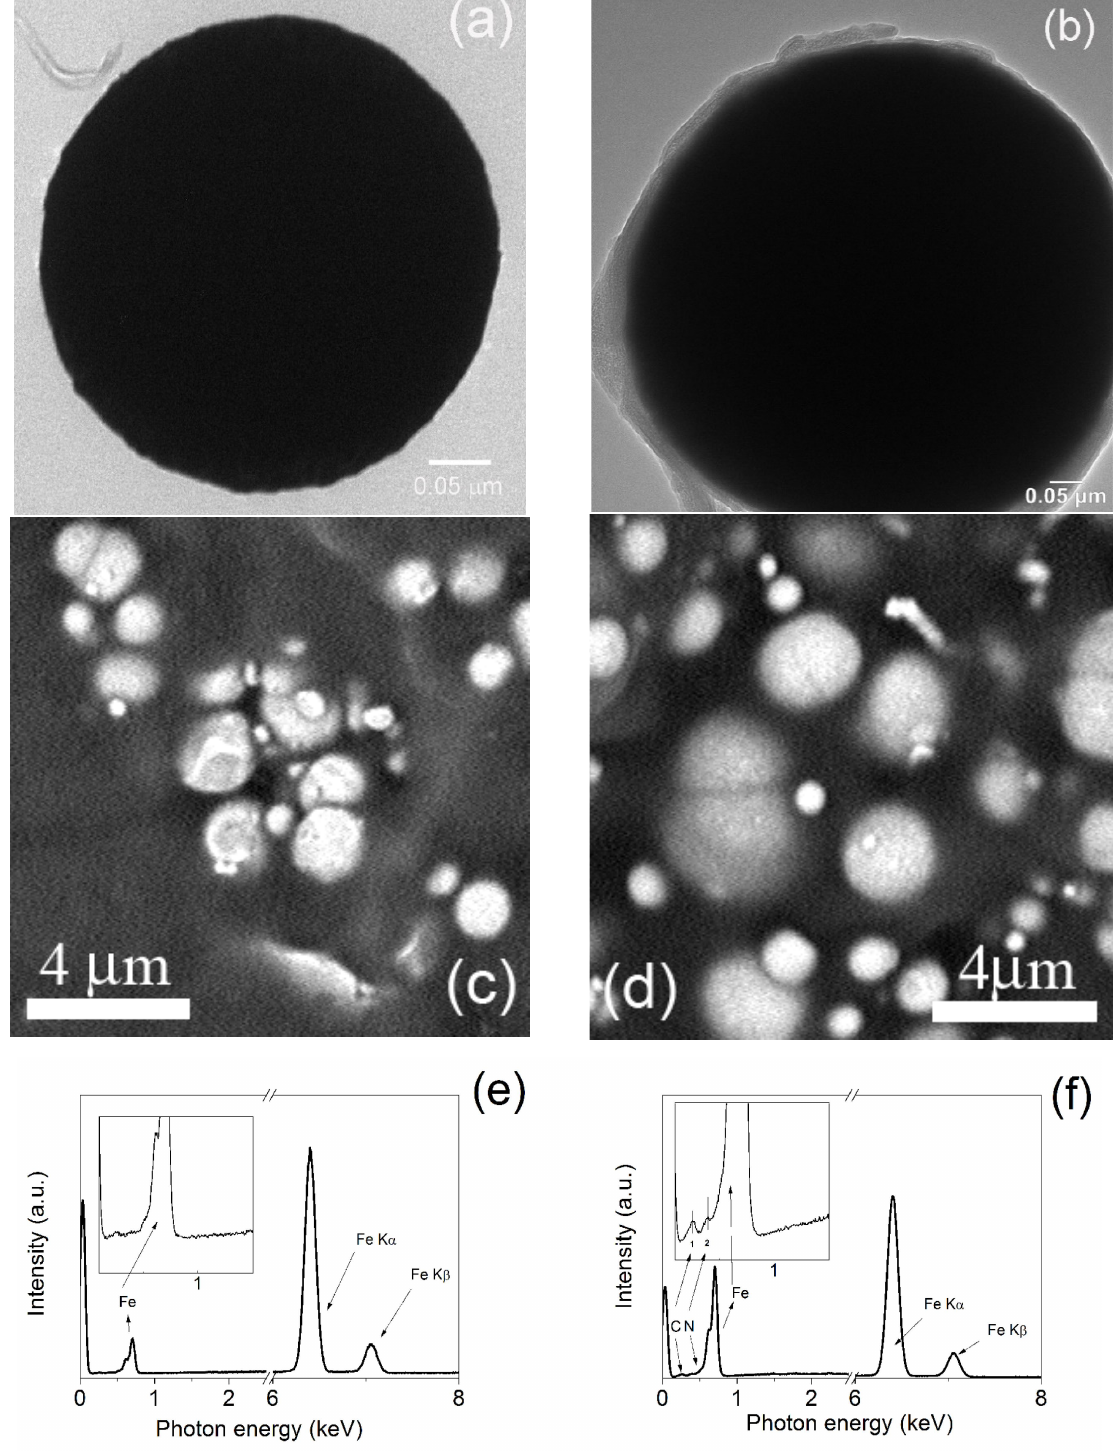
Figure 5. TEM images of the neat CI ( a ) and CI-PPEMA ( b ) particles. SEM images of the neat CI ( c ) and CI-PPEMA ( d ) particles in PDMS matrix and EDS spectra of the neat CI ( a ) and CI-PPEMA ( b ) particles. EDS of the neat CI ( e ) and CI-PPEMA ( f ). The numbers 1 and 2 in the figure ( f ) inset represents carbon and nitrogen elements,